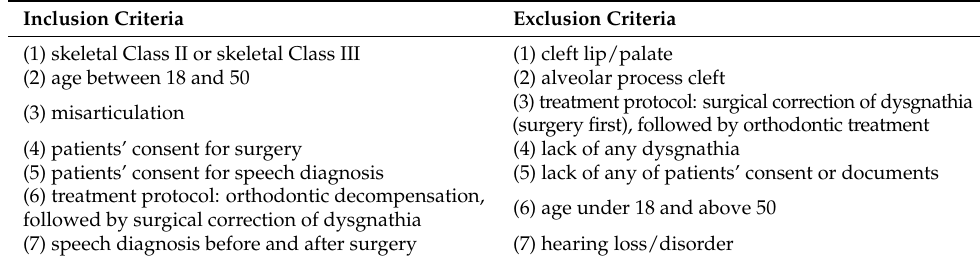
Table 1. Inclusion and exclusion